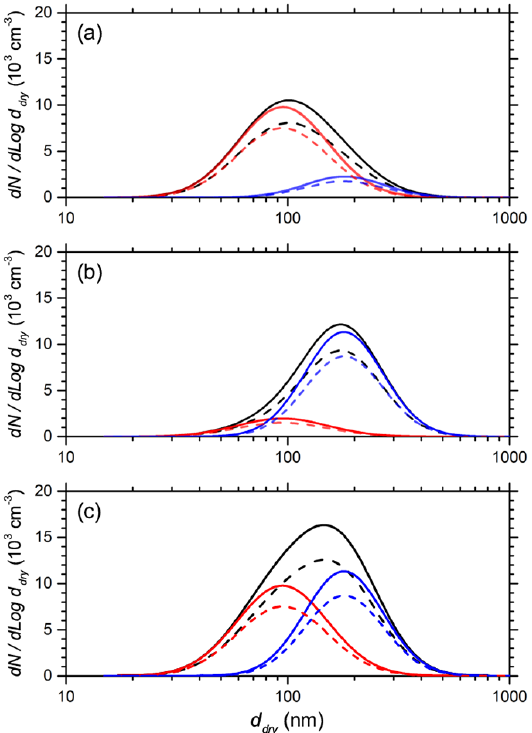
Figure 1. Schematic number size distributions for MP 5 , 1 (a) , MP 1 , 5 (b) and HP 5 , 5 (c) case studies. Total population (black, solid), Aitken (red, solid) and accumulation (blue, solid) modes are indicated. Particles in hygroscopic group κ p = 0 . 04 (dashed line, all colors) are also shown for a population average κ p